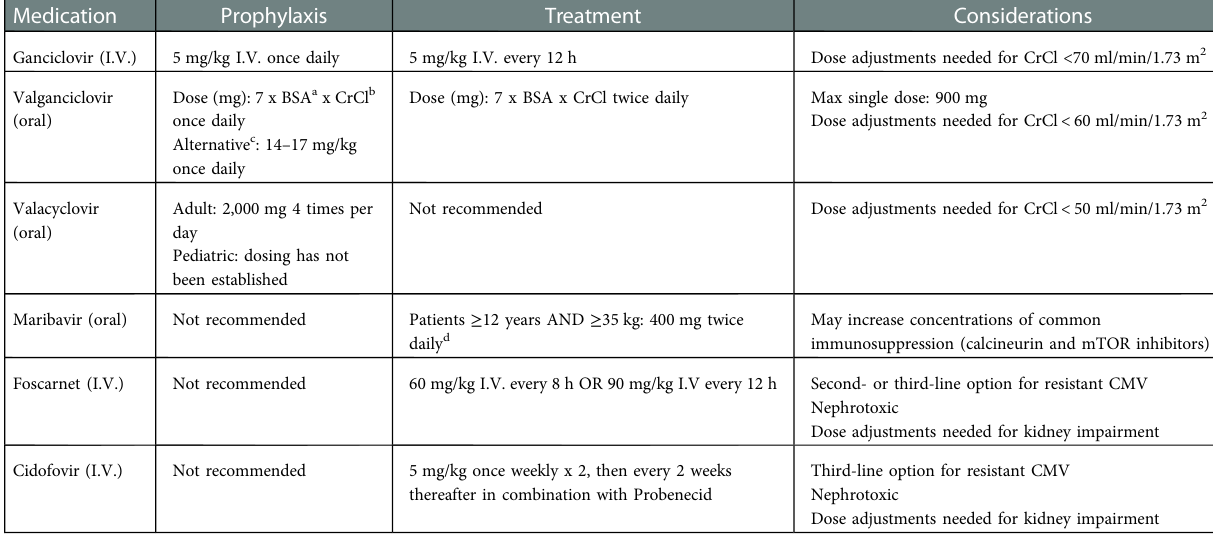
TABLE 2 Antiviral medications for CMV prevention and treatment in pediatric SOT. Medication Prophylaxis Treatment